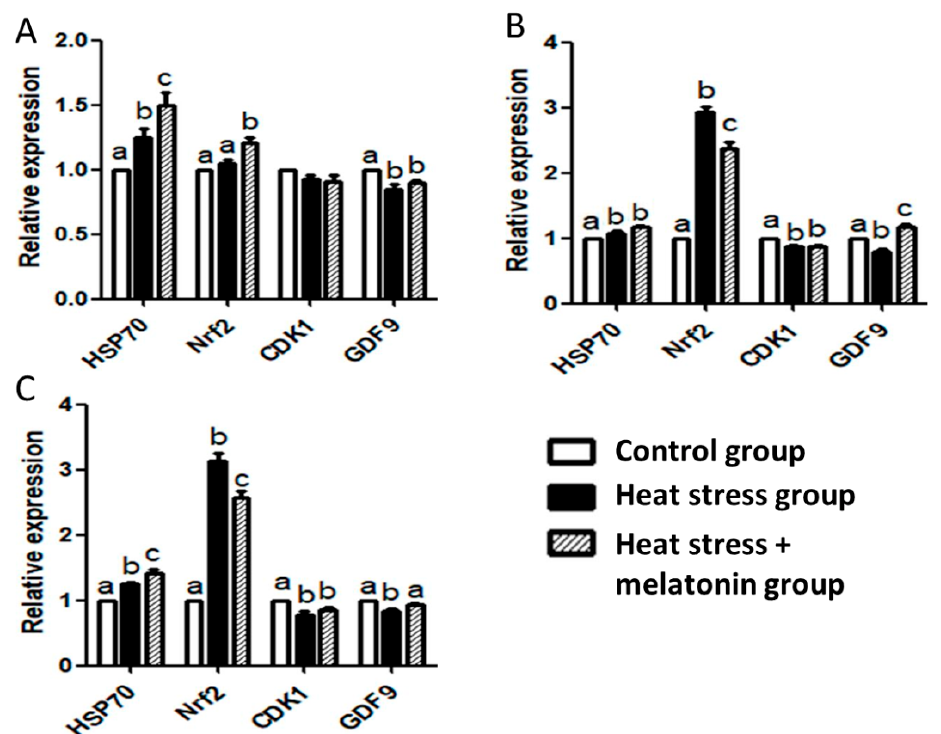
Figure 3. Effect of heat stress (HS) and melatonin on expression of HSP70 , NRF2 , CDK1 and GDF9 mRNA in the porcine oocytes during in vitro maturation (IVM). ( A ): effect of HS and melatonin on the oocytes during IVM at 4 h; ( B ): effect of HS and melatonin on the oocytes during IVM at 18 h; ( C ): effect of HS and melatonin on the oocytes during IVM at 42 h. Different letters: a,b,c in the different patterned columns represent significant difference ( p < 0.05).